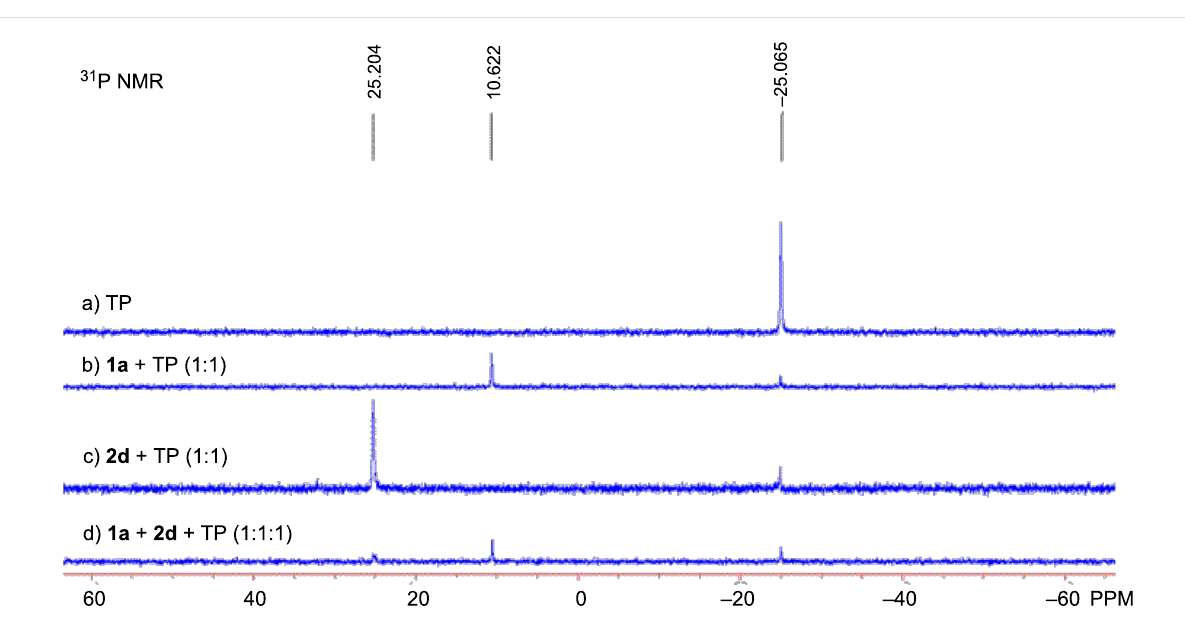
Figure 2: 31 P NMR spectra (161.9 MHz, CDCl 3 ) of control experiments.